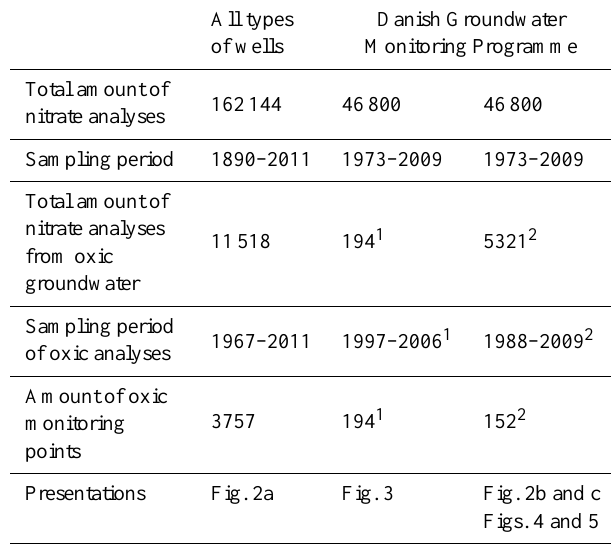
1 Nitrate analyses used for trend analyses on a national scale. CFC dated oxic monitoring